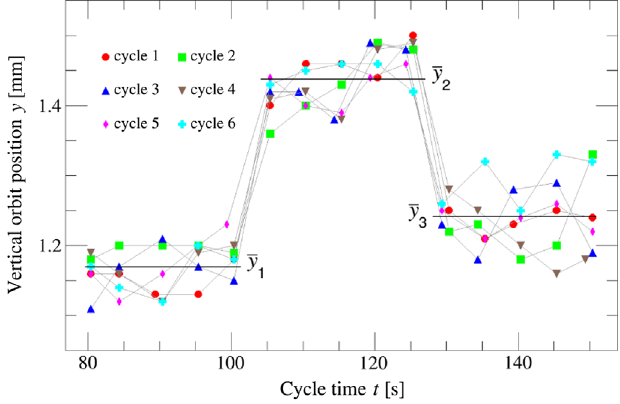
FIG. 7. Measurements of the vertical beam positions in BPM13 during six cycles, each ranging in cycle time from 80 to 150 s. The results shown were obtained with the same beam parameters and solenoid settings: S 1 ð χ 1 ¼ 0 Þ and S 2 ð χ 2 ¼ − 11 mrad Þ . The vertical orbit positions ¯ y ( i ¼ 1 , 2, 3), averaged over 6 cycles, are i calculated for the time intervals Δ T 1 and Δ T 3 when S 2 was switched OFF, and for time interval Δ T 2 when S 2 was switched ON. The numerical values of ¯ y are listed in Table II. i